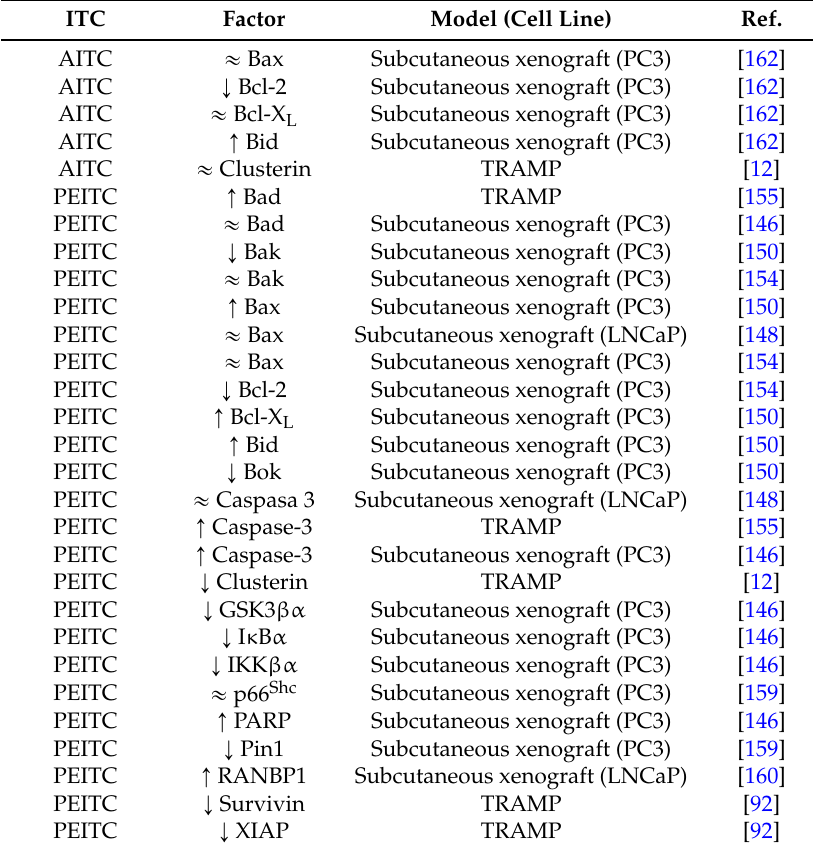
Table 6. ITCs inhibit the in vivo and ex vivo growth of prostate tumors by inducing apoptosis. ITC Factor Model (Cell Line)